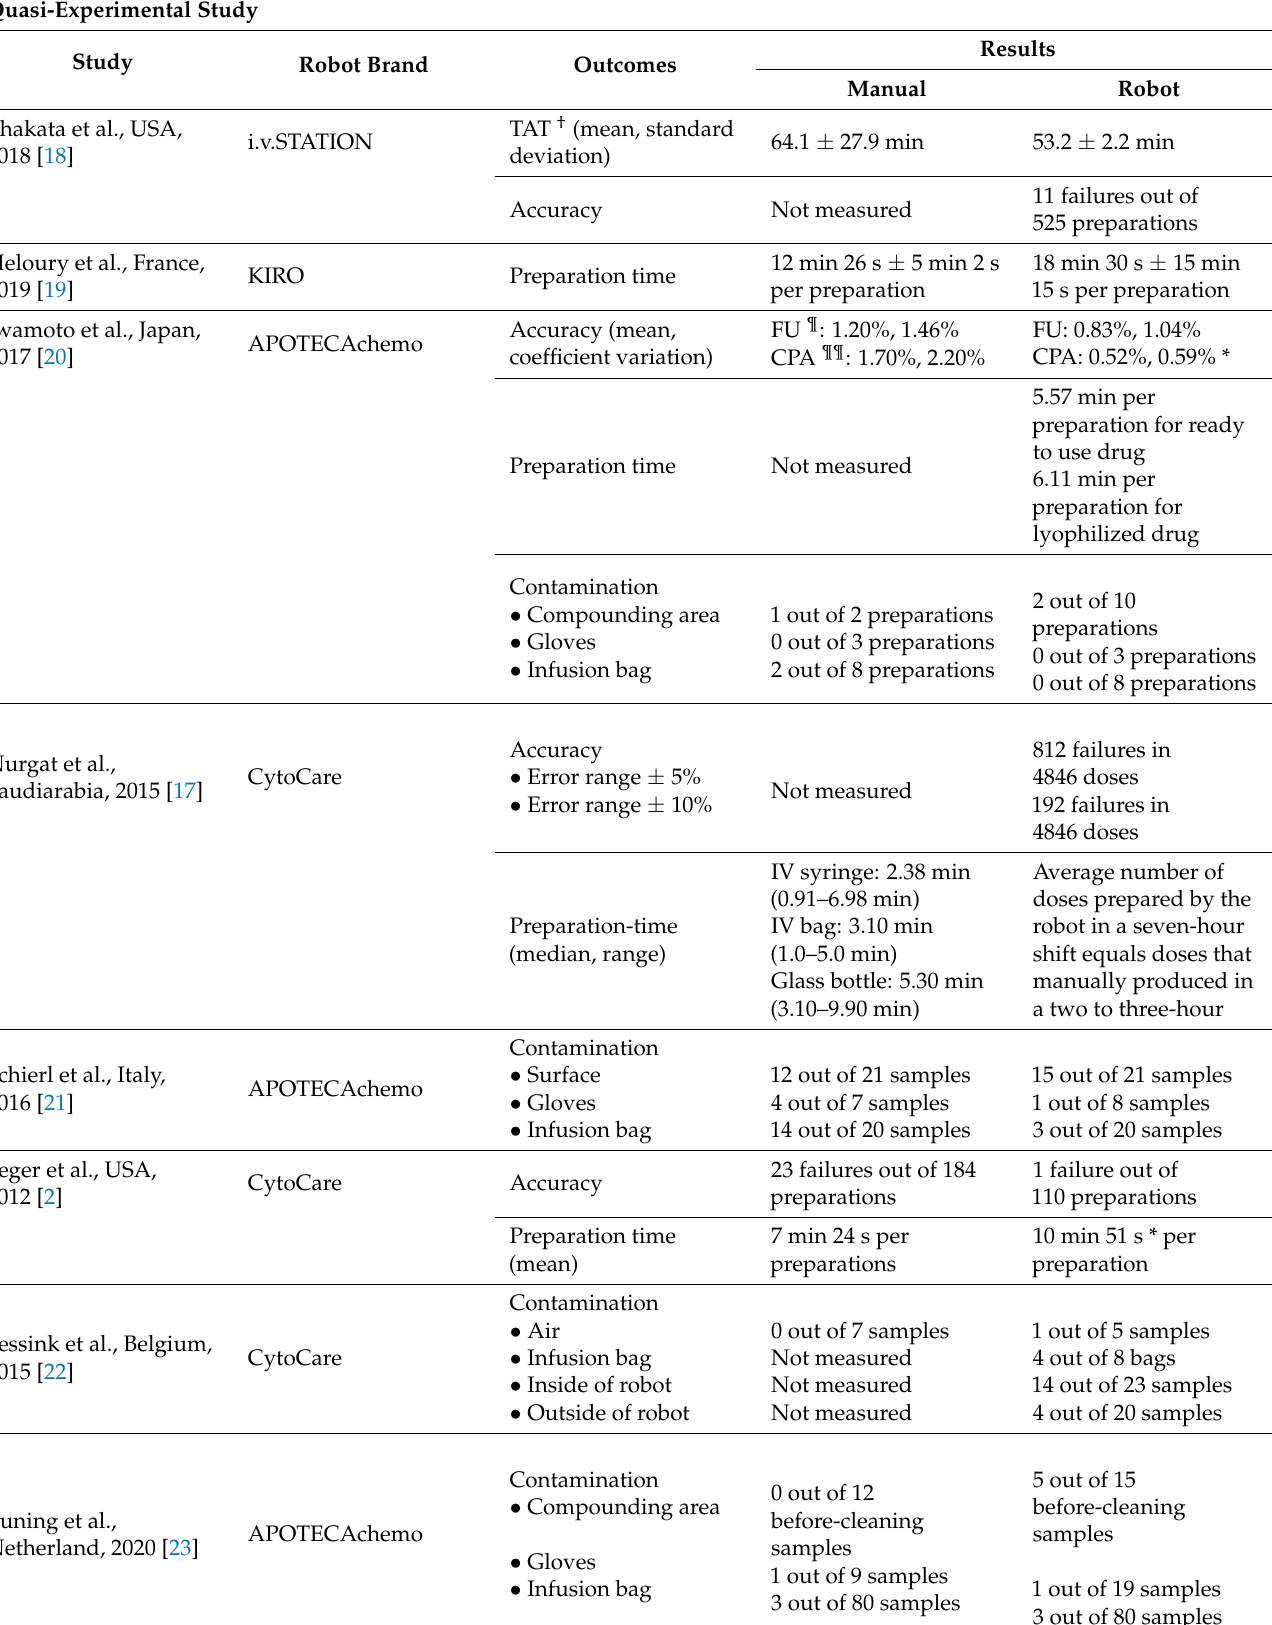
Table 1. Study characteristics and results of the systematic